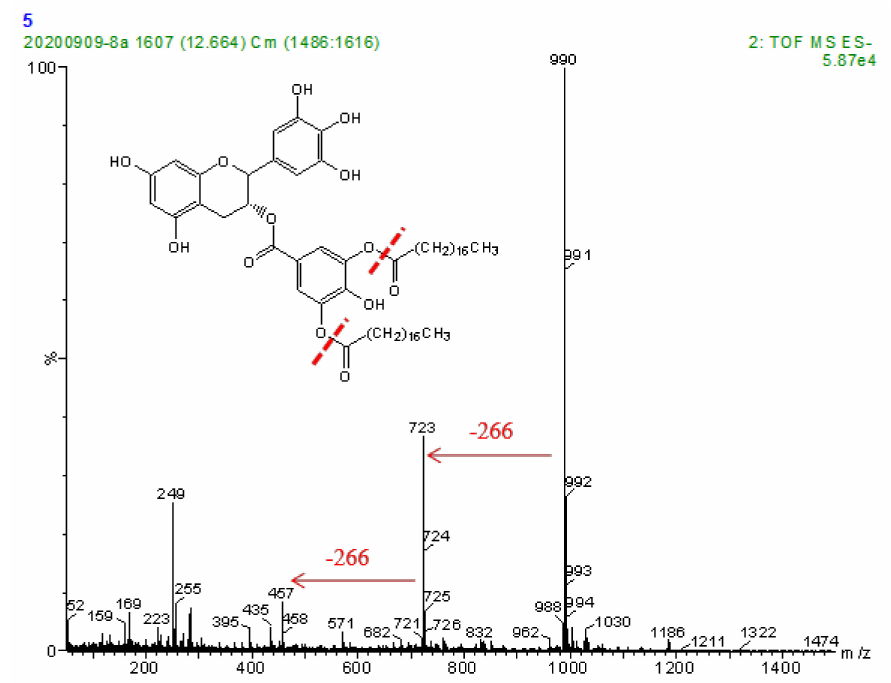
Figure 4. Mass spectra of EGCG stearyl derivatives.